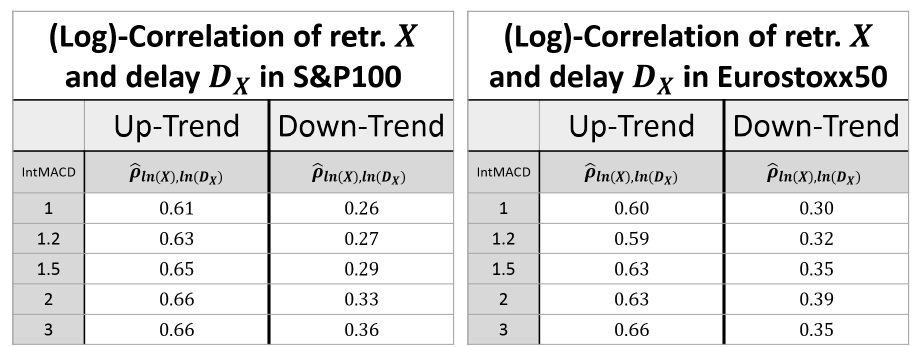
Table 3. Correlation between the logarithms of the retracement X (retr.) and delay D X (after retr.) in up- and down-trends. ( a ) S&P100 data. ( b ) Eurostoxx50